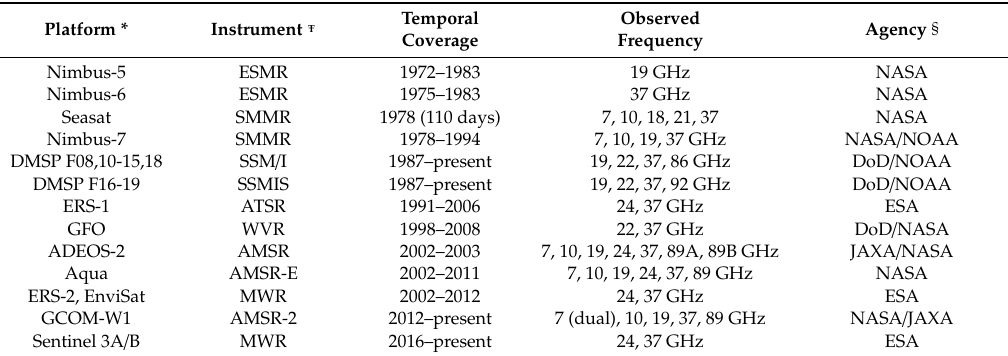
Table 4. Summary of passive microwave remote sensing platforms, instruments, temporal coverage, Table 1. Summary of radar and laser altimeter remote sensing platforms, instruments, temporal observed frequencies, and managing agencies. coverage, observed wavelength, and managing agencies.